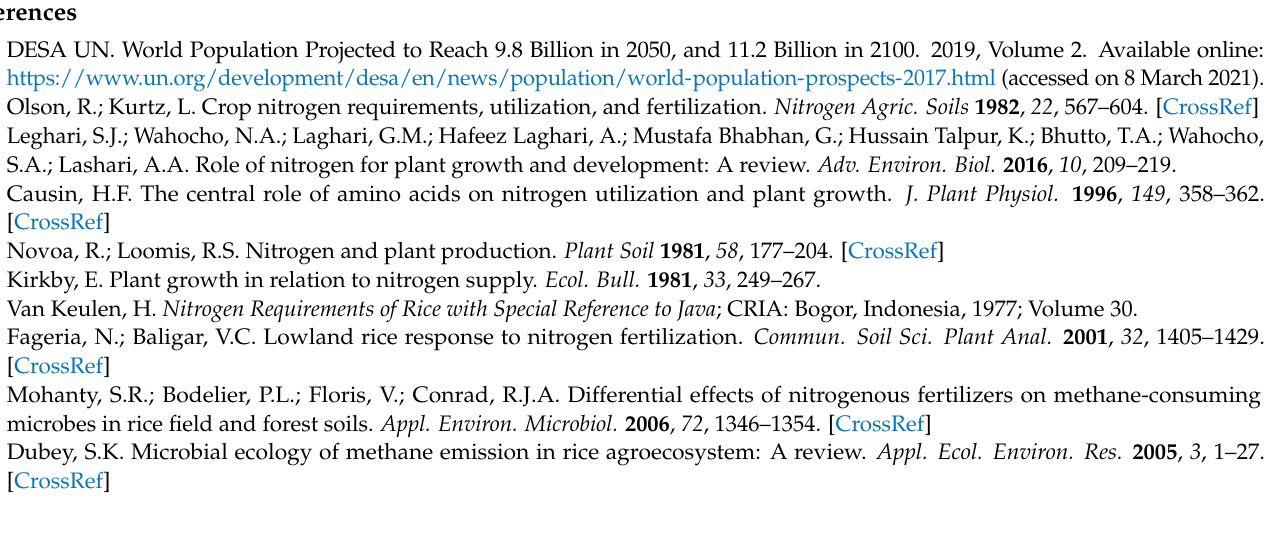
season of 2020, Figure S2: Quantile–Quantile plots, Table S1: Person r correlation between traits under normal nitrogen cultivation, Table S2: Person r correlation between traits under low nitrogen cultivation, Table S3: Shapiro Wilk W-statistic for the test of normality of the distribution, Table S4: List of candidate genes located within the qTNN4-1